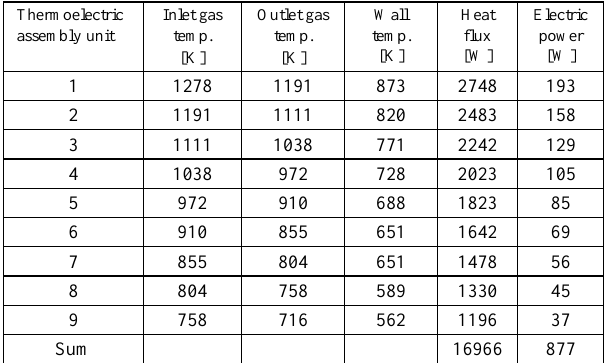
Table 2. Selected parameters of nine units for variable heat transfer factor during operation in full throttle at 6000 rpm Thermo- Inlet gas electric assem- bly unit